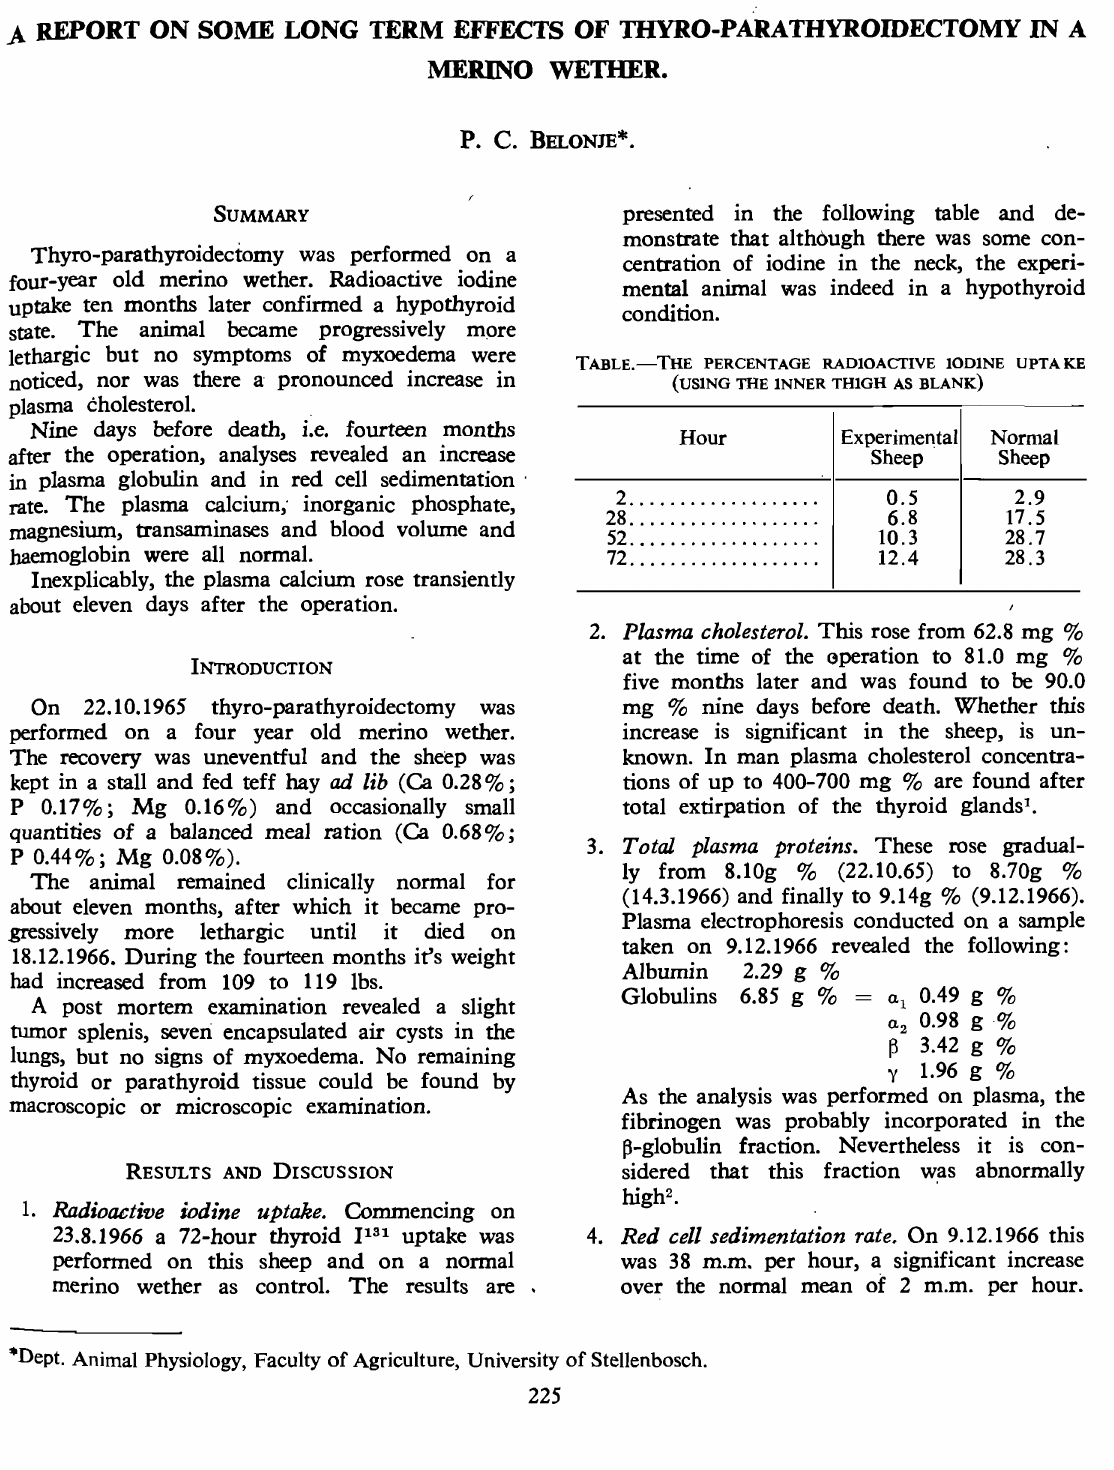
TABLE. -THE PERCENTAGE RADIOACTIVE IODINE UPTA KE (USING THE INNER THIGH AS